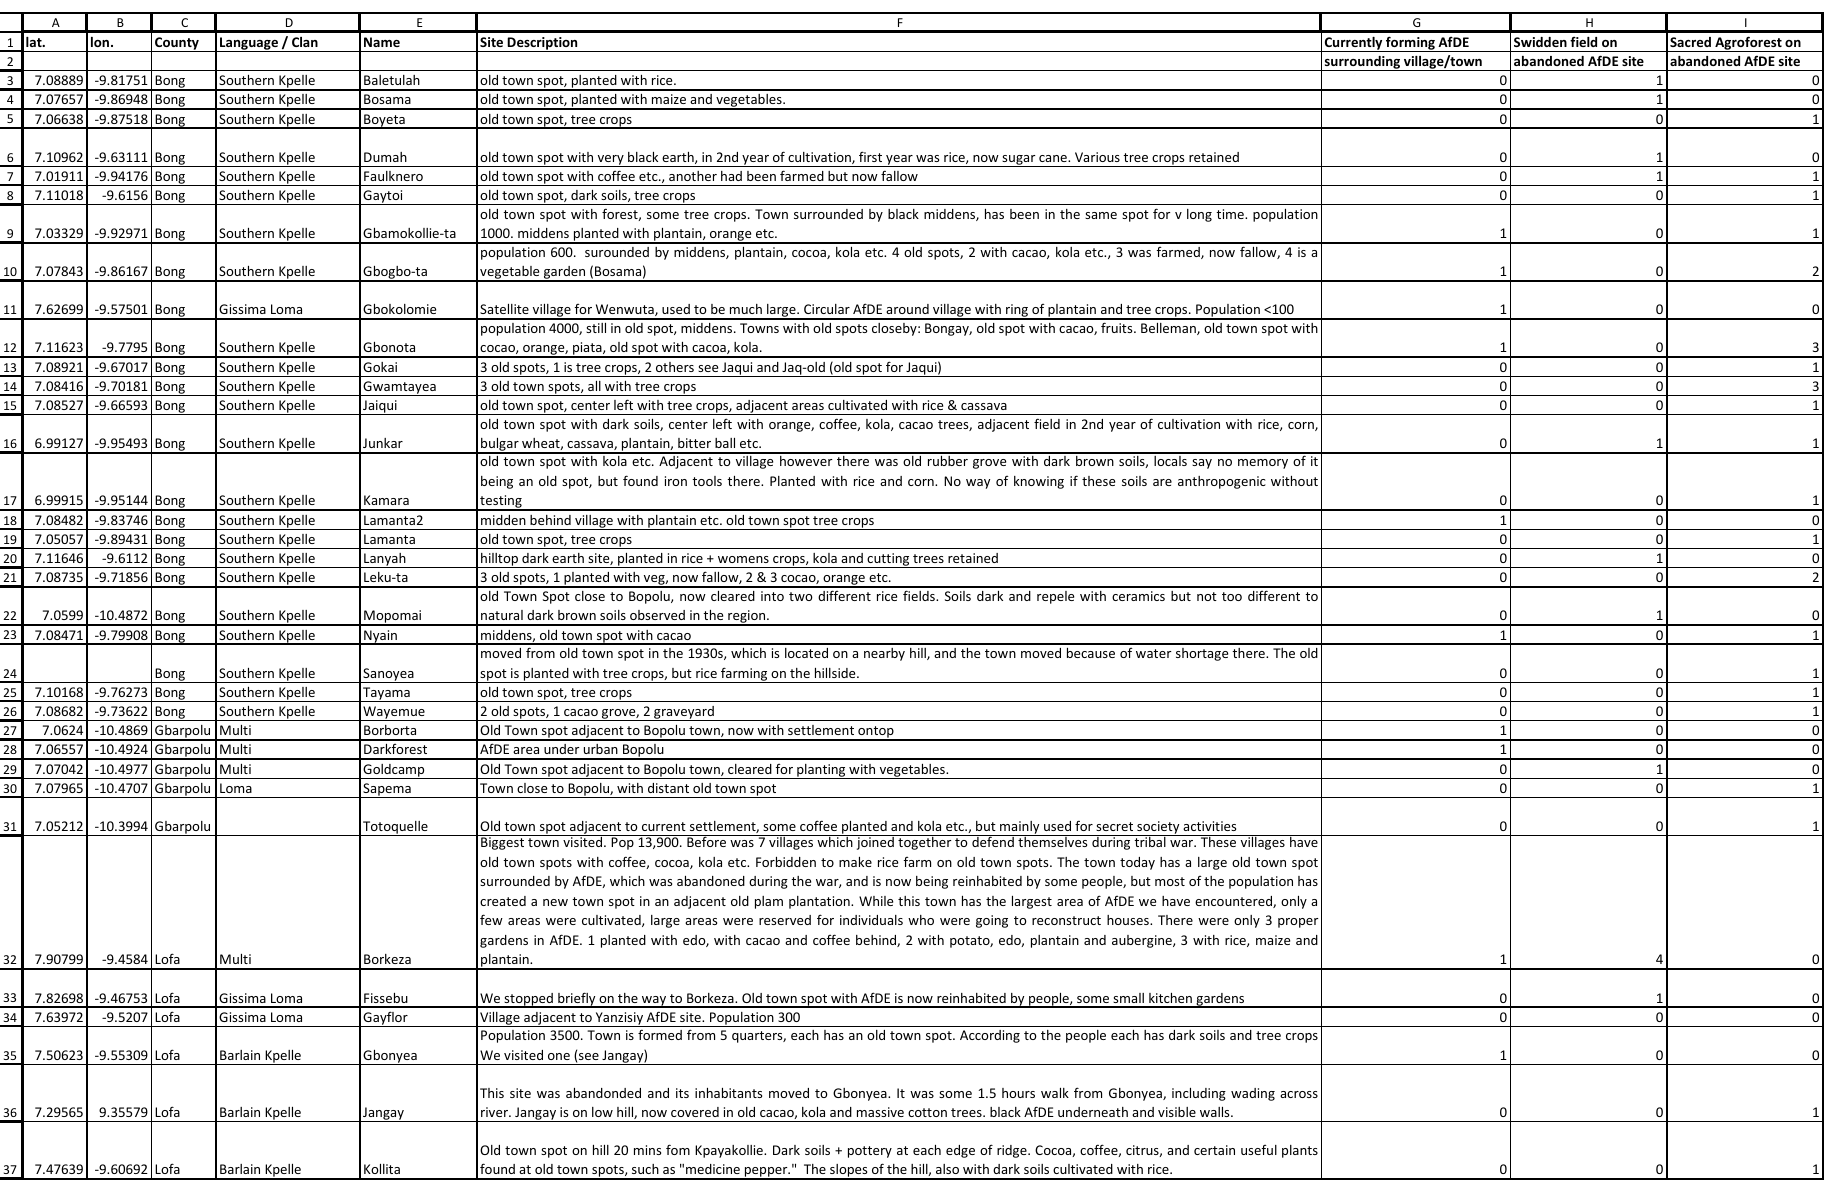
Table A1 .1 : Site description and kinds of AfDE encountered during regional